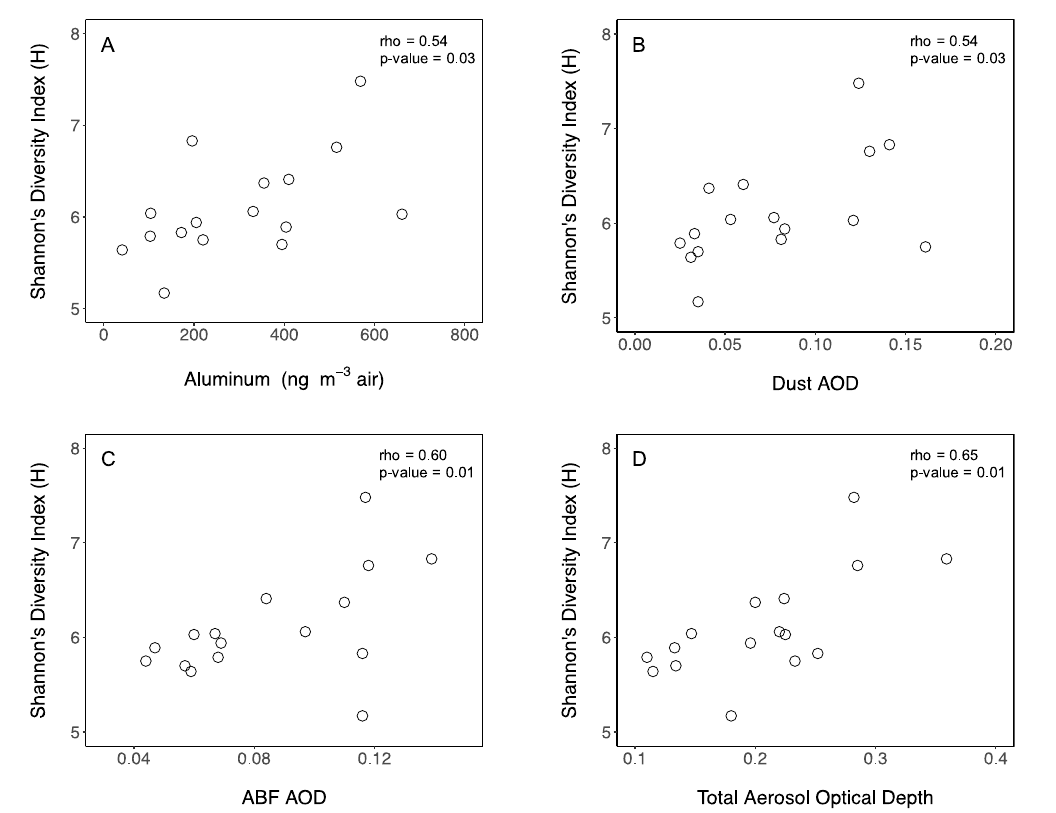
Figure 5. The relationship between bacterial diversity (Shannon’s diversity index) and atmospheric aerosols variables, ( A ) aluminum, ( B ) dust, ( C ) ABF, ( D ) total aerosol optical density .